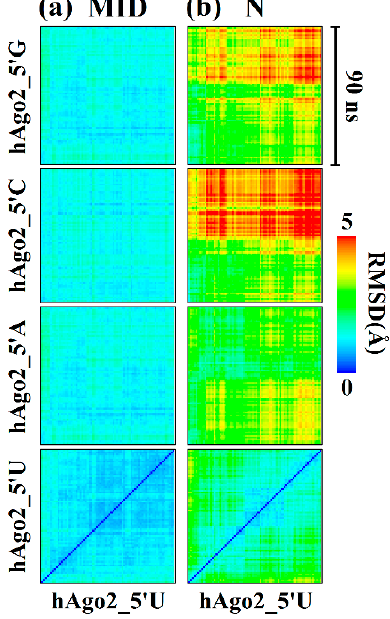
Figure 3. Cross-RMSD plots of hAgo2 MID ( a ); and N-terminal ( b ) domain. Cross-RMSD were calculated after superimposition on backbone atoms of the MID and N domains. The different 5 ′ -bases are indicated on the left. While the RMSDs (color-coded with a gradient from 0 to 5 Å) reveal very little changes in the MID domain between the various 5 ′ -end guides, a clear difference can be observed in the N-terminal domain with gradually increasing RMSDs when switching form 5 ′ -U to 5 ′ -G end guides.